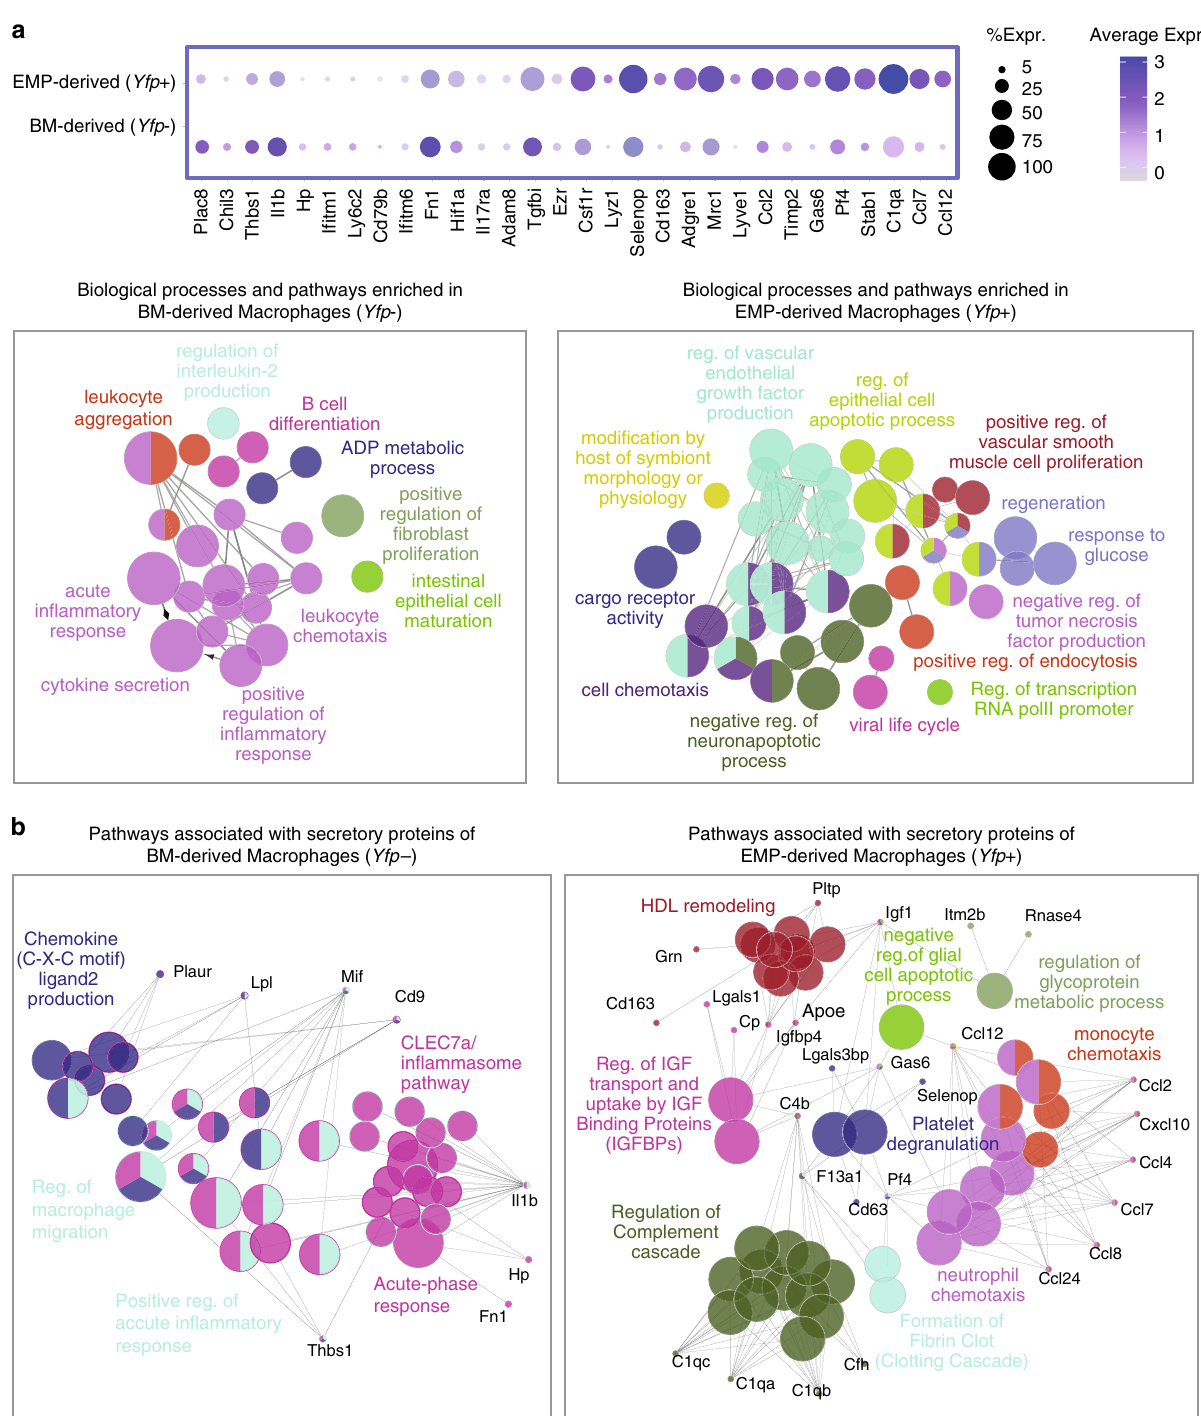
Fig. 7 Biological network analysis of genes associated with macrophage clusters. GO term and pathway analysis of EMP- and BM-derived macrophages in response to AngII. a Dot plot showing the top 15 genes, which are differentially expressed between EMP- and BM-derived macrophages (upper panel). Functionally grouped networks (lower panels) depicting biological processes and pathways associated with genes that are signi fi cantly upregulated in Yfp + or Yfp − macrophages ( p value < 0.05, Log2FC > 0.25). Each node represents a speci fi c biological process or pathway, and edges indicate the relations between different terms based on their kappa score level (>0.4). Nodes of the same color belong to functionally similar terms or pathways. The node size represents the term enrichment signi fi cance ( P value < 0.0005 to <0.05). b Networks of functionally grouped pathways and processes associated with secretory markers of Yfp + or Yfp − macrophages. Genes with capability of producing secretory proteins were shortlisted from all signi fi cantly upregulated genes in each population and subjected to pathway enrichment analysis. The marker genes are identi fi ed using Seurat FindMarker function based on Wilcoxon Rank Sum test. ClueGo performs the enrichment test based on the hypergeometric distribution and Bonferroni